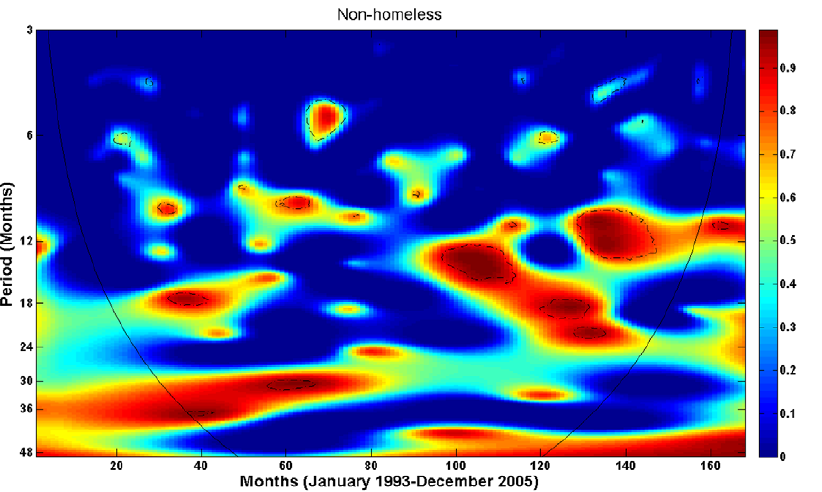
Figure 5. Wavelet coherence between the non-homeless TB cases and their HIV + /PPD 2 contacts, January 1993–December 2005. Except for patches of high coherence at various periodic scales appearing transiently in time, there is no evidence of consistently significant